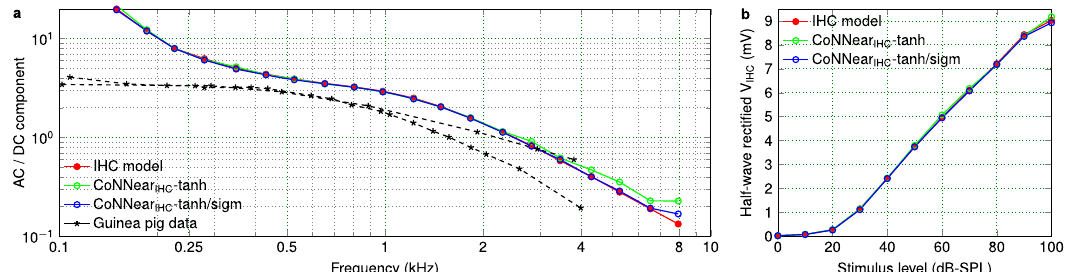
Fig. 3 Comparing IHC transduction aspects. a Ratio of the AC and DC components of the IHC responses (Metric 2) across CF for 80-dB-SPL pure-tone bursts compared against guinea-pig data 63 . b Root-mean-square of the half-wave recti fi ed IHC receptor potential V IHC in response to a 4-kHz pure tone plotted as function of sound level (Metric 3).